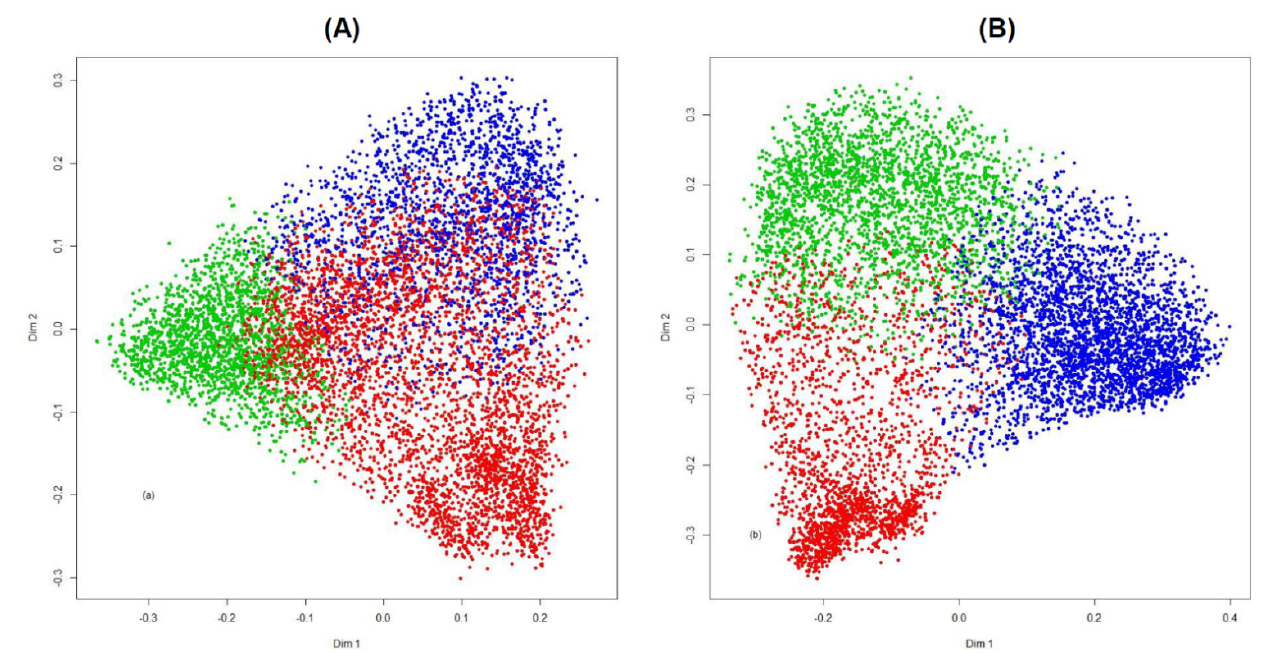
Figure 2. ( A ) Plot of the 7910 β -thalassemia patients visualized using a multidimensional scaling plot based on the random forest (RF) dissimilarity of all 19 indicators of phenotype severity (IPhS). ( B ) Plot of the 7910 β -thalassemia patients visualized using a multidimensional scaling plot based on the RF dissimilarity of the 6 most important IPhS. Points of the same color represent patients belonging to the same cluster. Patients are colored by their cluster membership (red for Cluster 1, green for Cluster 2, and blue for Cluster 3). Table 2. Results from supervised random forest validation procedure to check the predictive accuracy of the used